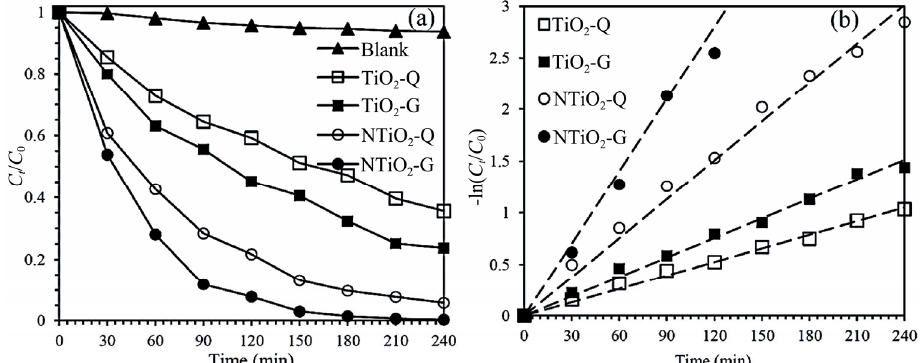
Fig. 8 (a) Visible light photocatalytic activity of the different thin films in degradation of paraoxon, and (b) calculation of the corresponding reaction rate constant ( k ) based on the pseudo-first-order kinetic model. systems for practical applications is their stability and re